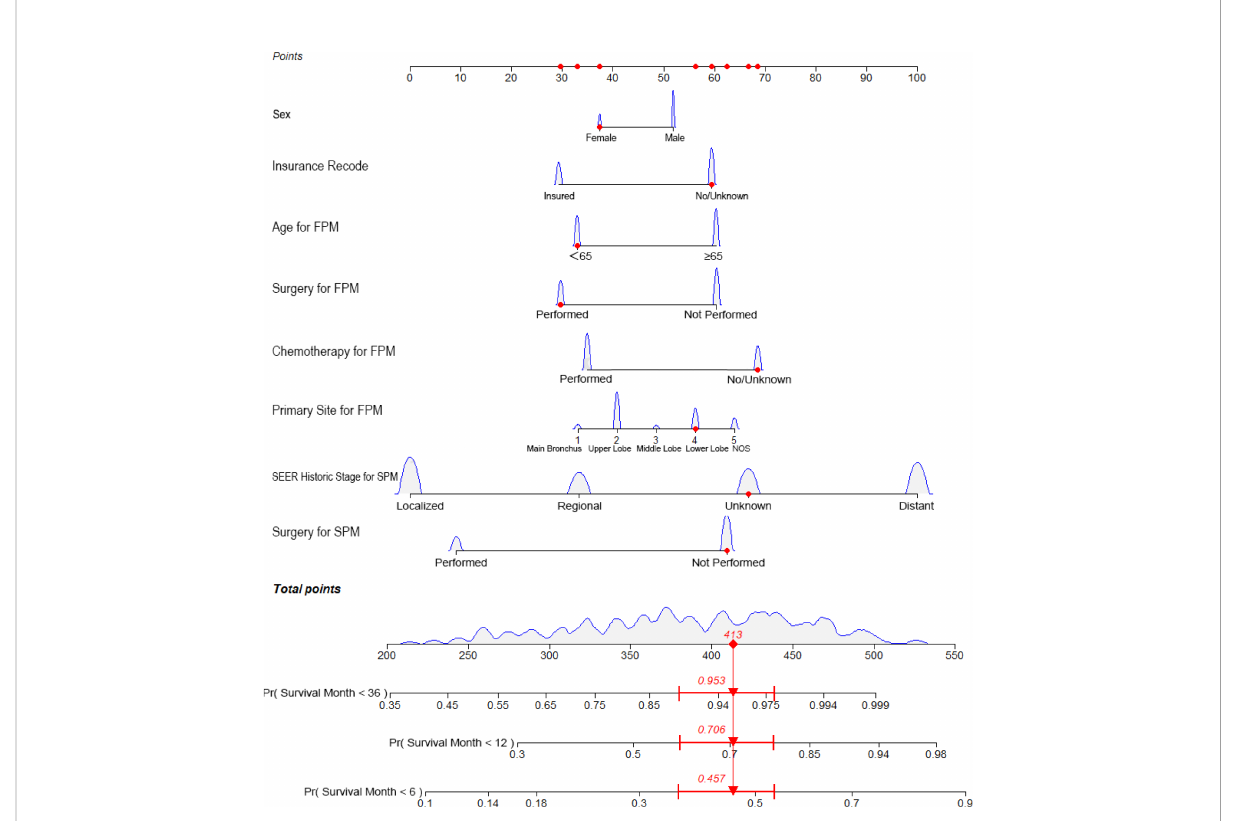
FIGURE 1 Nomogram predicting the 6-month, 1-year, and 3-year OS rates of patients with second primary lung cancer in esophagus cancer. The nomogram summed the points identi fi ed on the scale for each variable. FPM, fi rst primary malignancy; SPM, second primary malignancy; OS, overall